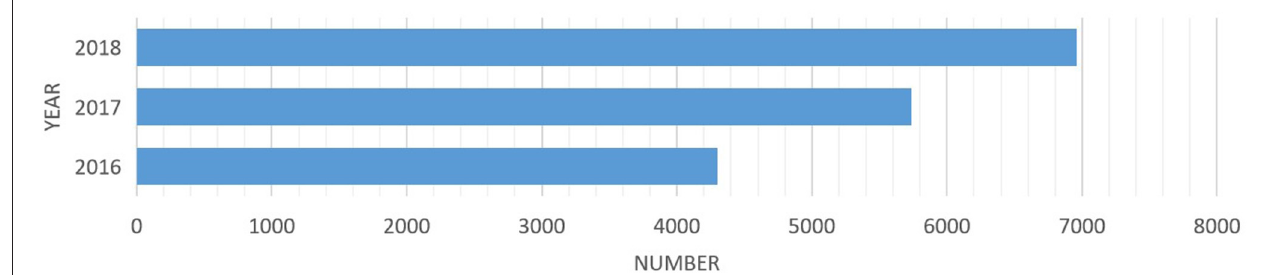
FIGURE 1 | The number of makerspaces in 2016 − 2018.